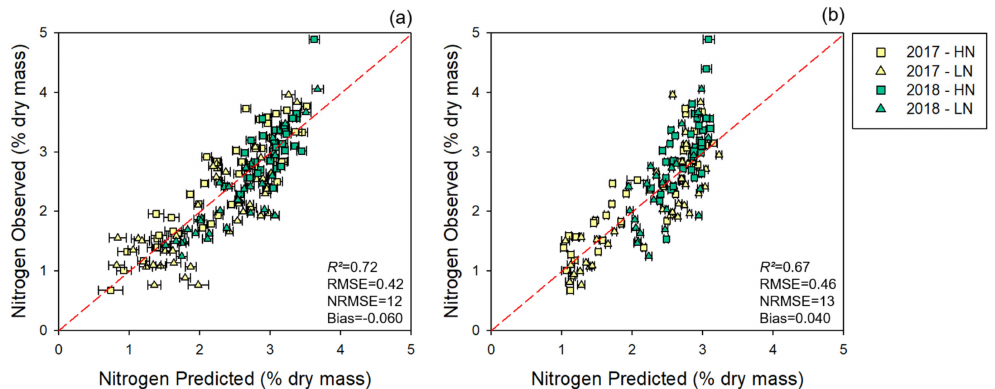
Figure 4. Multi-year models: observed vs. predicted external validation values of nitrogen levels derived from the multi- year dataset. ( a ) External validation of nitrogen estimates generated using leaf-level spectral measurements. ( b ) External validation of nitrogen estimates generated using canopy-level spectral measurements. 2017: 2017 dataset, 2018: 2018 dataset. Error bars for estimated values represent the standard deviation generated from 500 model permutations using an 80:20 calibration:cross-validation approach. Dashed line: 1:1 relationship. R 2 : model goodness of fit; RMSE: root-mean-square error; NRMSE: normalized root-mean-square error.